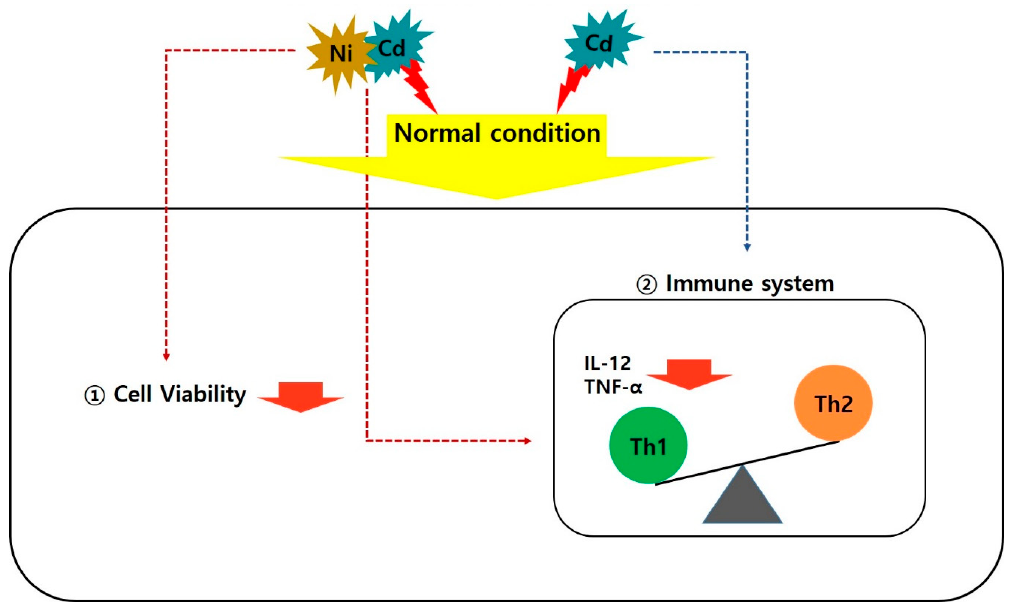
Figure 4. Schematic of cell viability and cytokine production after heavy metal exposure.